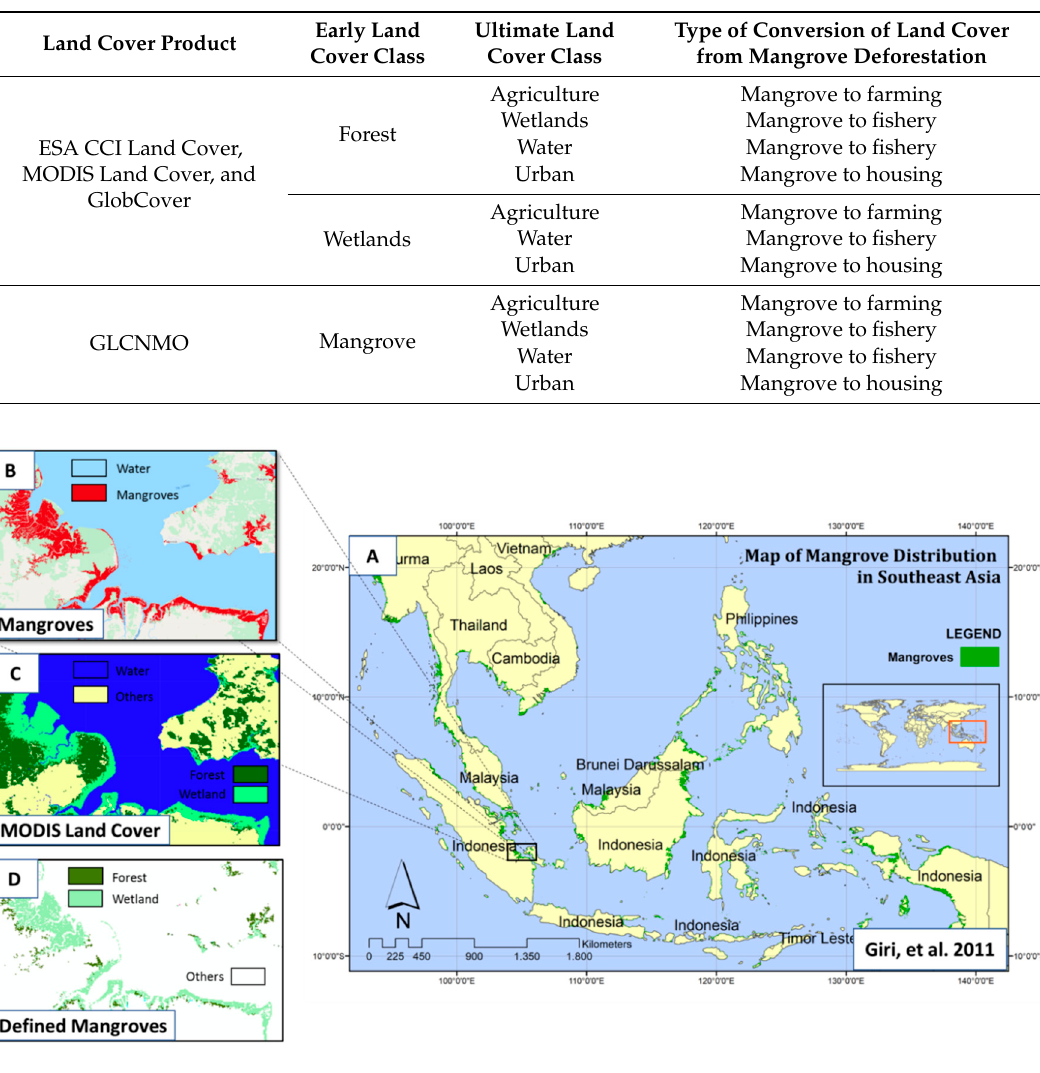
Figure 2. Illustration of how to define mangroves based on forest and wetland classes of ESA, GlobCover, and MODIS Land Cover products. ( A ) Mangroves distribution across Southeast Asia generated from MFW datasets [40]. ( B ) Mangrove patches in the northeast of Palembang, South Sumatra as sample area. ( C ) MODIS Land Cover Products that will be reclassified into mangroves and non-mangroves classes. ( D ) The result of reclassification scheme, i.e., forest and wetland classes defined as